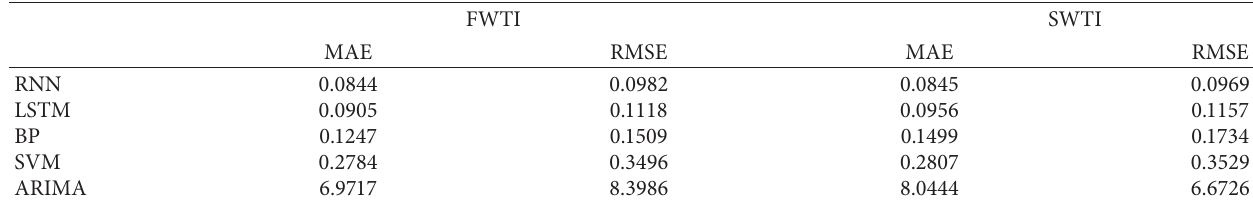
Table 7: Errors of benchmark